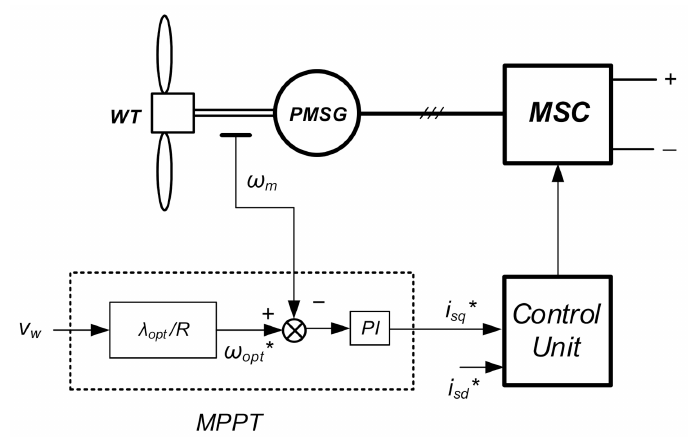
Figure 12. TSR (Tip Speed Ratio) control of Maximum Power Point Tracking (MPPT) for wind